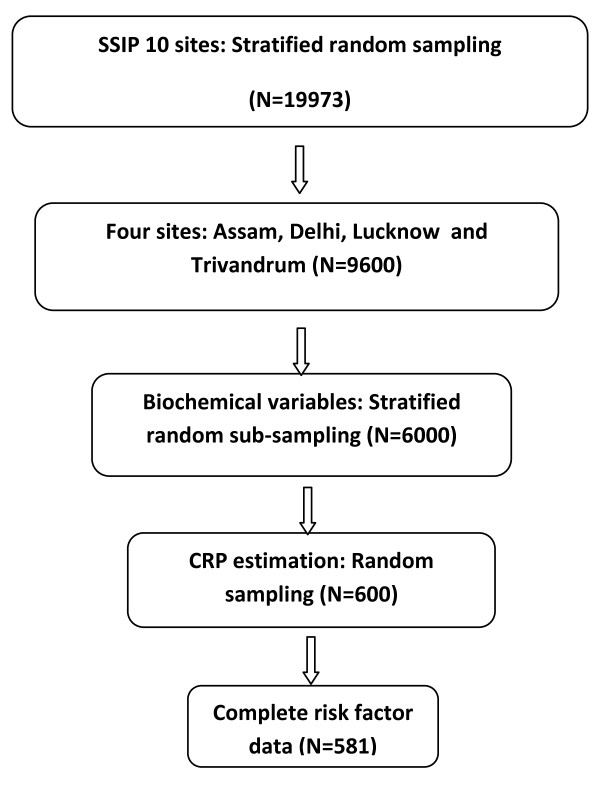
Study flow chart. SSIP, sentinel surveillance study in Indian industrial population